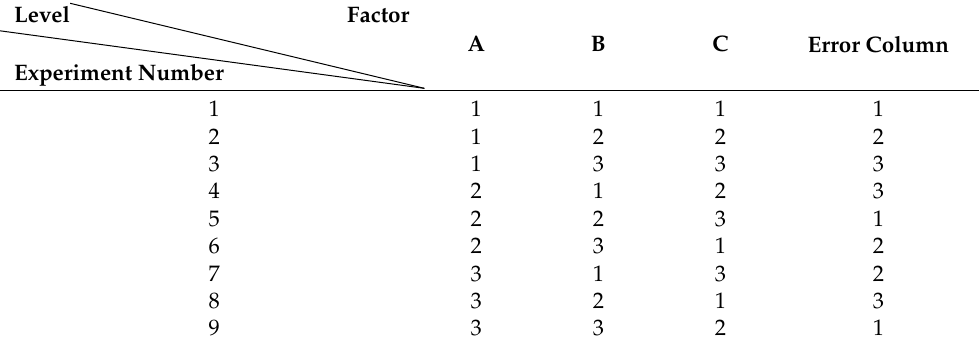
Table 2. Orthogonal table of mechanical parameters of fuze airflow-induced acoustic generator.